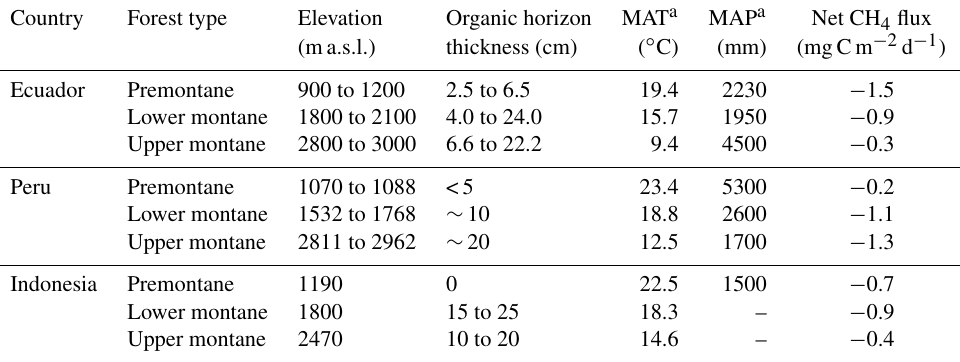
Table 5. Characteristics and annual mean net CH 4 fluxes reported for montane forests in Peru (this study), Ecuador (Wolf et al., 2012) and Indonesia (Purbopuspito et al.,